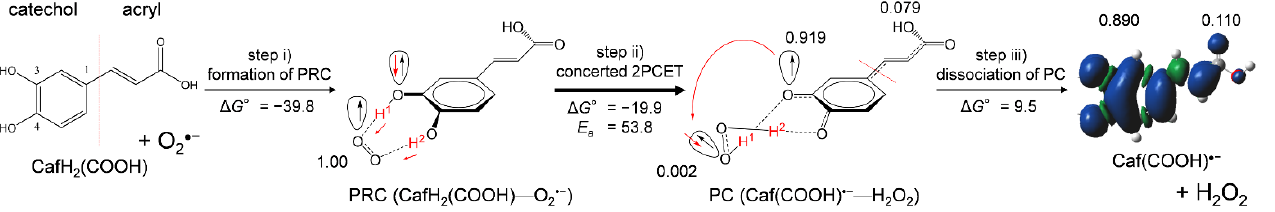
CV parameters, Figure S1: In situ electrolytic ESR/UV-vis system, Table S2: Optimized geometry of system, Table S2: Optimized geometry of caffeic acid, Figure S2: Energy profiles along IRC of caffeic acid, Figure S2: Energy profiles along IRC of 2PCET between CafH 2 (COO − ) and O 2• − , Tables S3–S6: Optimized geometry of TS.